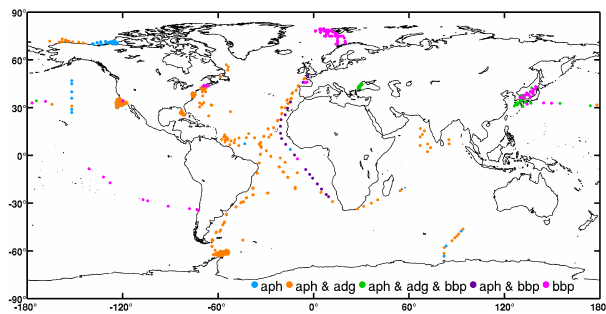
Figure 14. Global distribution of observations of inherent optical properties (algal pigment absorption coefficient aph, detrital plus CDOM absorption coefficient adg and particle backscattering coef- ficient bbp) in the final table.